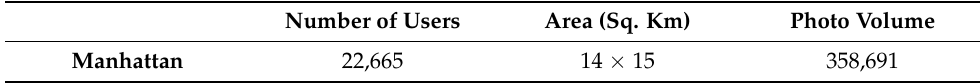
Table 1. Main Flickr photo data statistics for Manhattan.